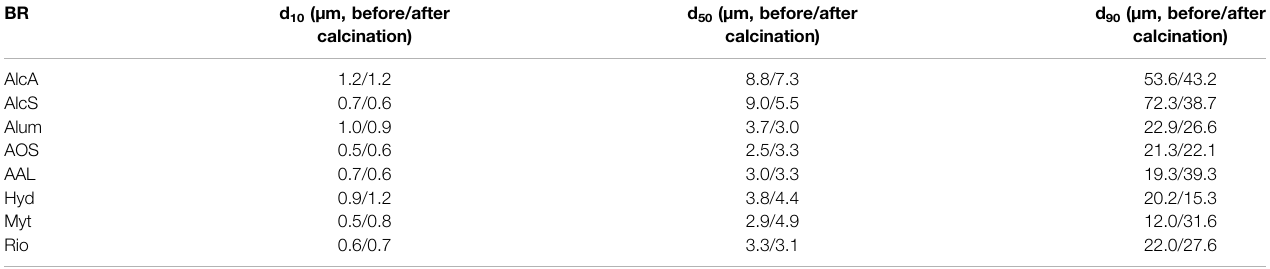
d 50 (µm, before/after calcination)